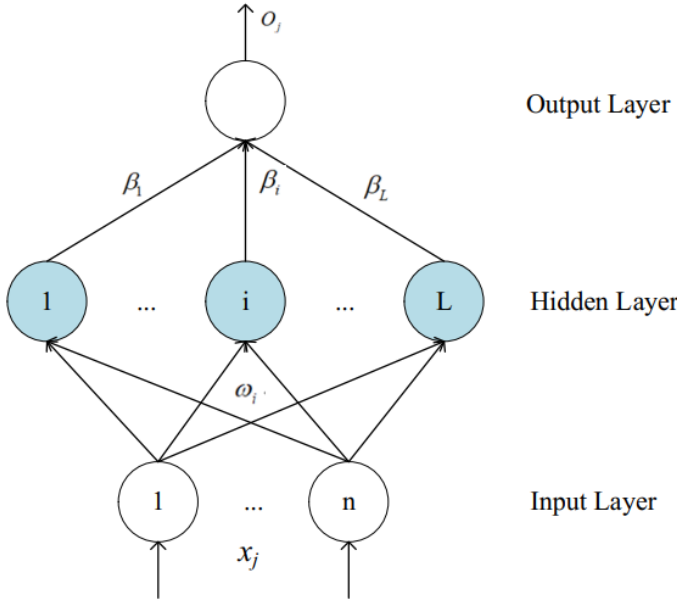
Figure 8. Feed-forward network with a single hidden layer [52] .